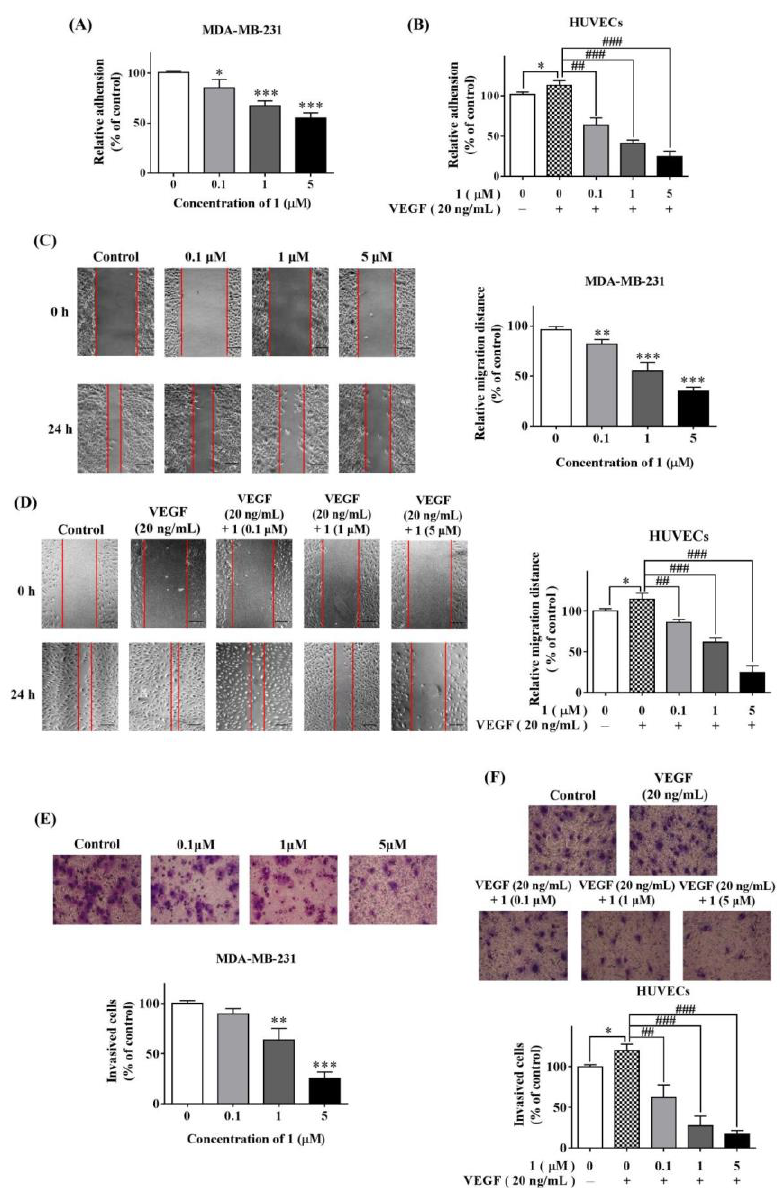
Figure 2. Compound 1 suppressed MDA-MB-231 cells and HVUECs adhesion, migration and invasion. The effect of 1 on MDA-MB-231 cells ( A ) and HUVECs ( B ) adhesion was determined by cell-adhesion assay. Wound-healing assay was performed to examine the role of 1 in suppressing MDA-MB-231 cells ( C ) and HUVECs ( D ) migration. 1 suppressed MDA-MB-231 cells ( E ) and HUVECs ( F ) invasion, which was assessed by transwell assay. ( n = 3, means ± SEM are shown; * p < 0.05, ** p < 0.01, *** p < 0.001, compared with control (0.1% DMSO), ## p < 0.01, ### p < 0.001, compared with VEGF only).